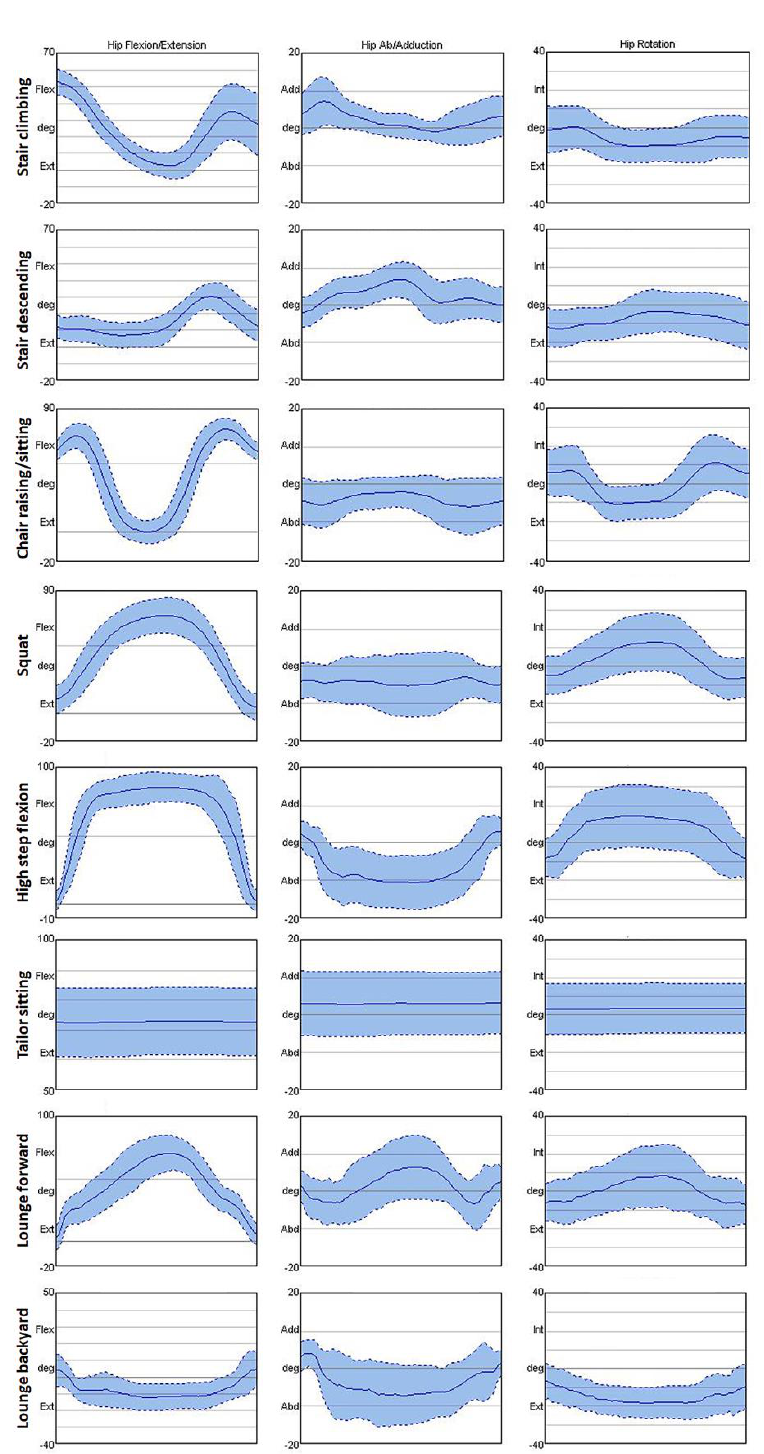
Figure 4. Patterns of the joint rotation at the replaced hip in the three anatomical planes (columns) for each of the motor tasks in the GA. Bands are the same as in Figure 3. each of the motor tasks in the GA. Bands are the same as in Figure